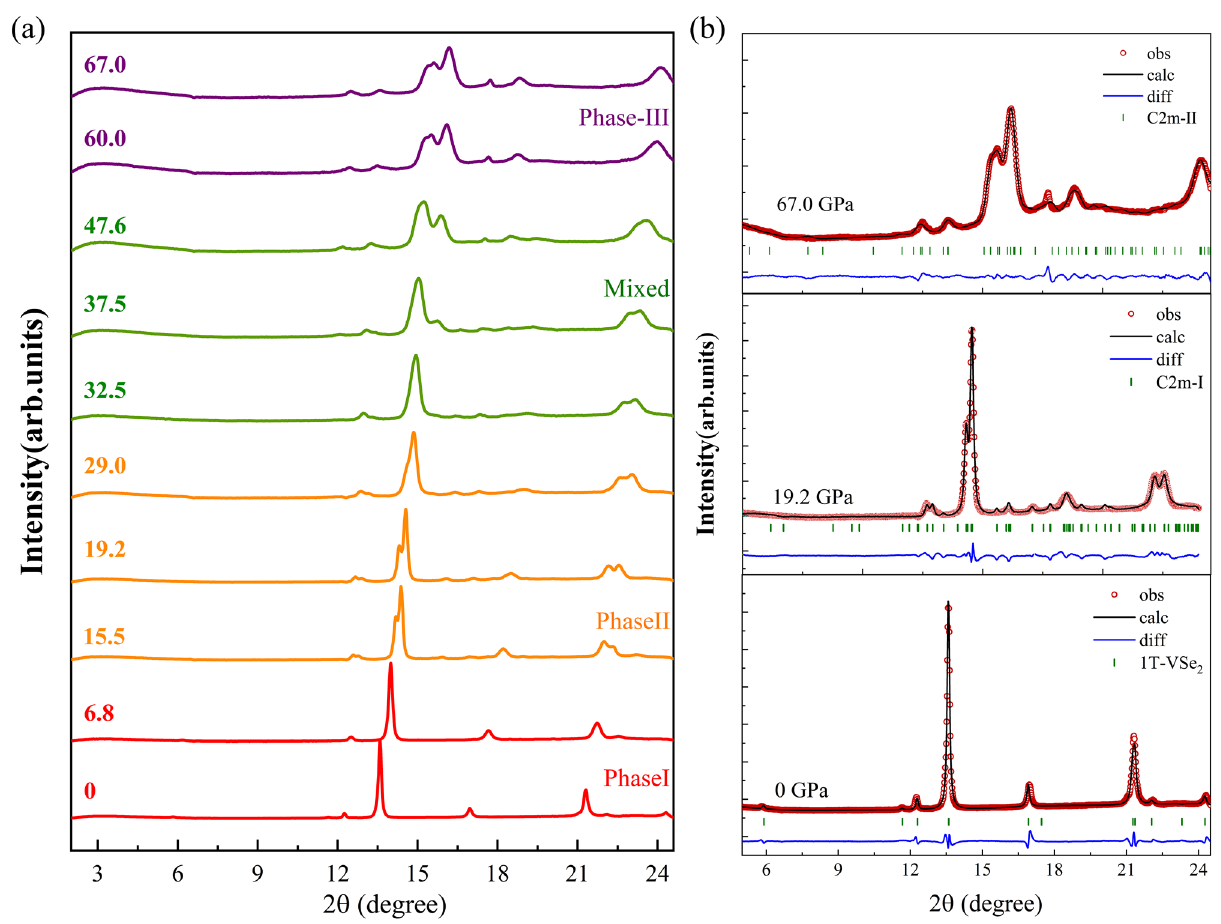
Figure 5. ( a ) selected data of high-pressure XRD experiments up to 67.0 GPa. ( b ) Experimental (red circles) and Rietveld-refined XRD pattern (black line) for bulk VSe 2 at 0, 19.2, and 67.0 GPa, respectively. The solid blue lines at the bottom are the residual intensities and the vertical bars indicate the peak positions. The refining parameters are R wp = 3.2%, χ 2 = 0.45 for 1T phase, R wp = 2.6%, χ 2 = 0.30 for C2/m -I, and R wp = 1.5%, χ 2 = 0.11 for C2/m -II phase,